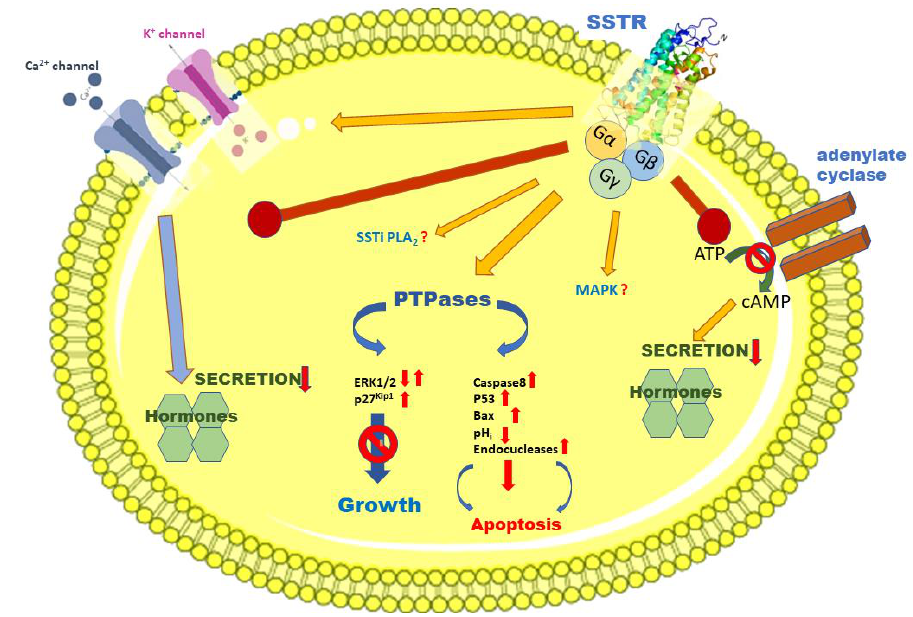
Figure 4. SSTR-based potential downstream pathways and signaling cascades leading to the modulation of hormone secretion, cell growth, and apoptosis. (based on references [10–12,15,37] with